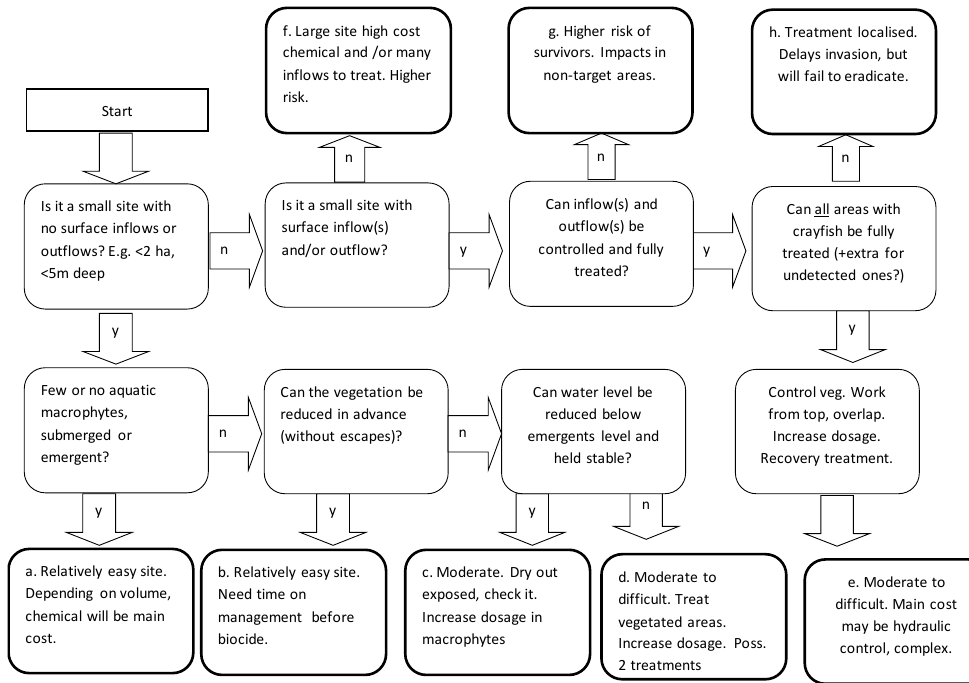
Figure 5. The decision tree for initial appraisal of a potential biocide treatment on a site with a population of invasive signal crayfish.